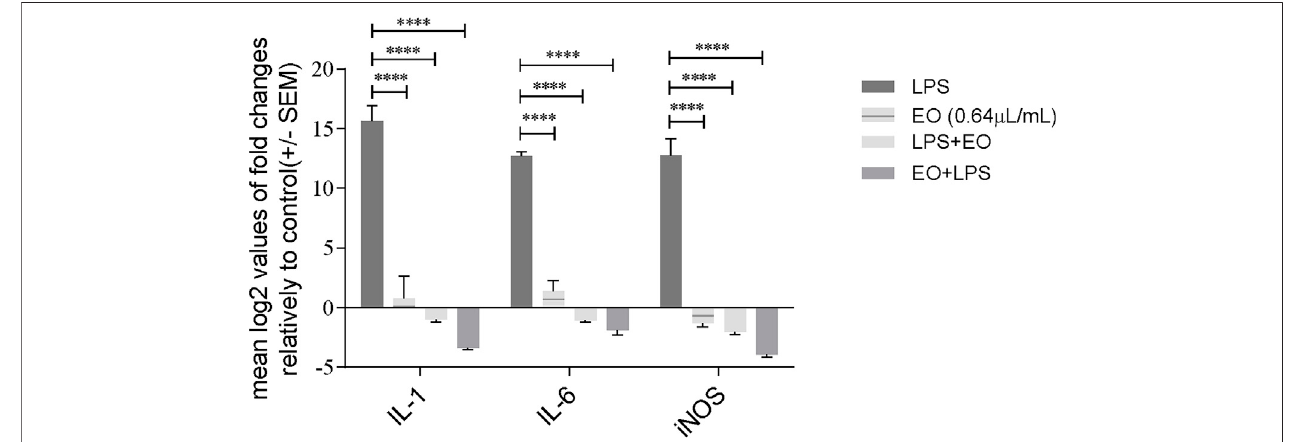
FIGURE5| ModulationofLPS-induced transcription ofpro-in fl ammatorygenes Il1b , Il6 and Nos2 by L.viridis L´Hér.essentialoiladdedsimultaneouslyor1 hprior toLPS.CellsweretreatedwithLPSduring6 h.ThemRNAlevelswereassessedbyquantitativeReal-TimeRT-PCR.Geneexpressionisindicatedasmeanlog2valuesof foldchangesrelativelytocontrolandnormalizedto HPRT1 housekeepinggene.Eachvaluerepresentsthemean ± SEM.fromthreeindependentexperiments.Statistical differences between groups were calculated by two-way ANOVA followed by Dunnet ’ s post hoc test (****p < 0.0001, compared to LPS).